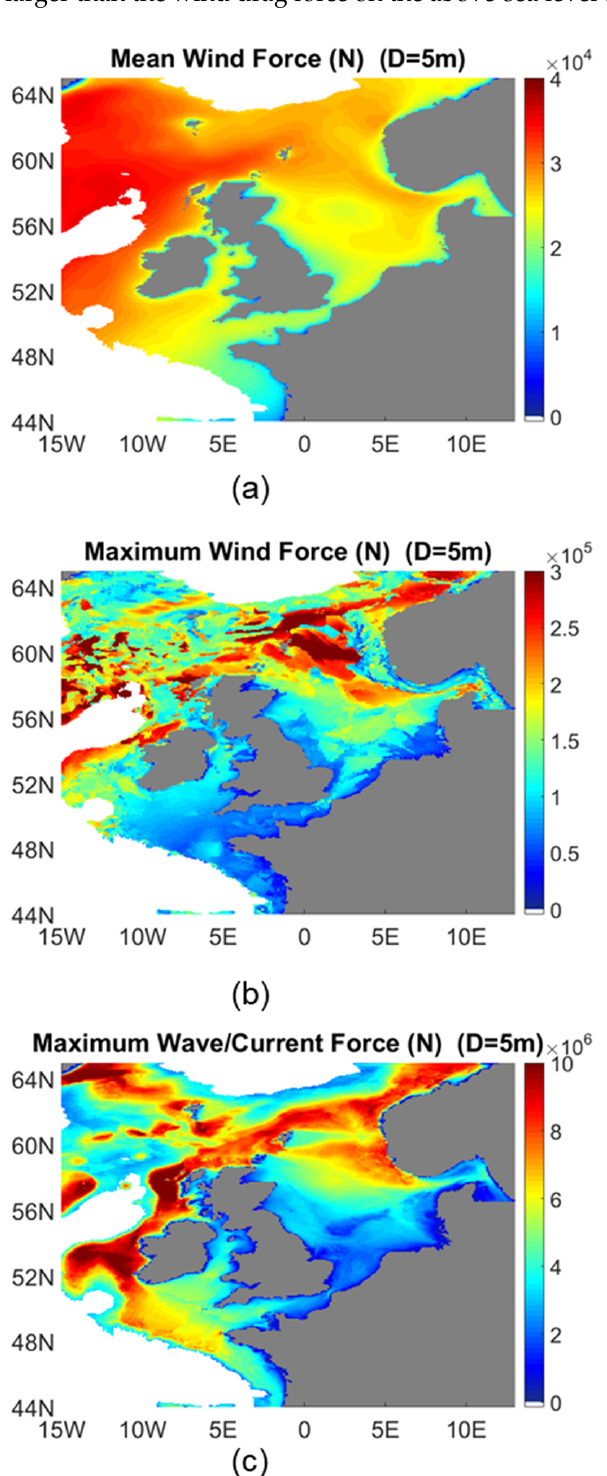
Figure 13. Spatial maps of temporal mean wind drag force ( a ), maximum wave force wind drag force ( b ), and wave/current force ( c ), on a monopile of diameter D = 5 m, above sea level height of the pile is 100 m, and deployment depth up to 2000 m, from Met Office FOAM and WaveWatch III model outputs on the AMM7 grid (~7 km) over period July 2014 to June 2016.